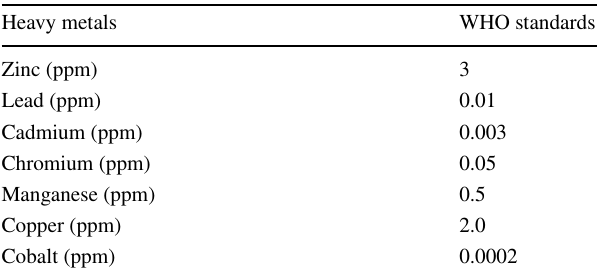
Table 3 Standards of permissible limits of various parameters of rain- water (Anonymous, WHO 2006)